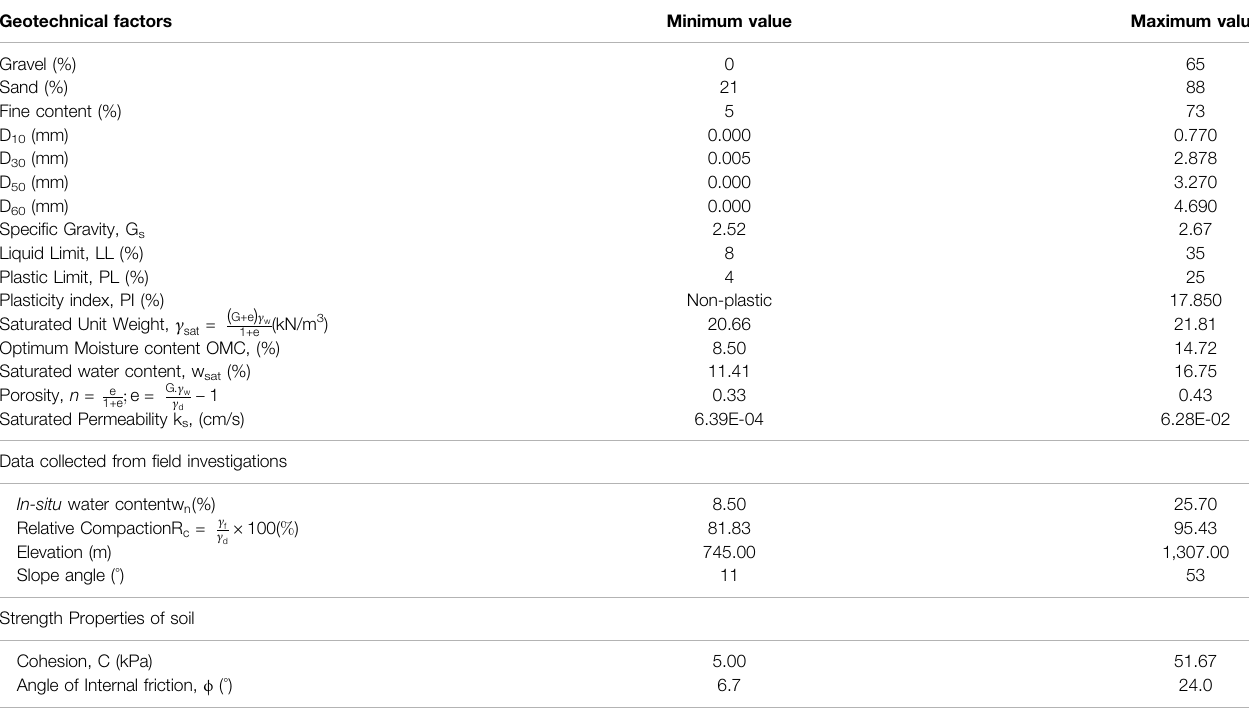
TABLE 3 | Range of values of the geotechnical factors across 60 locations.